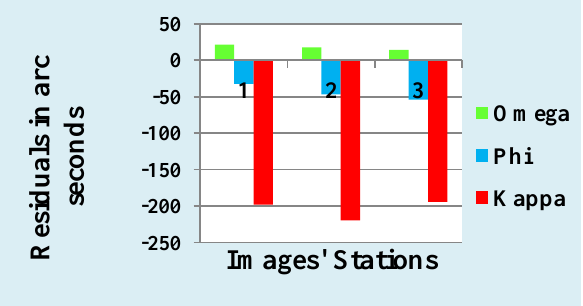
Figure 3. Shows the orientation residuals of images taken in the